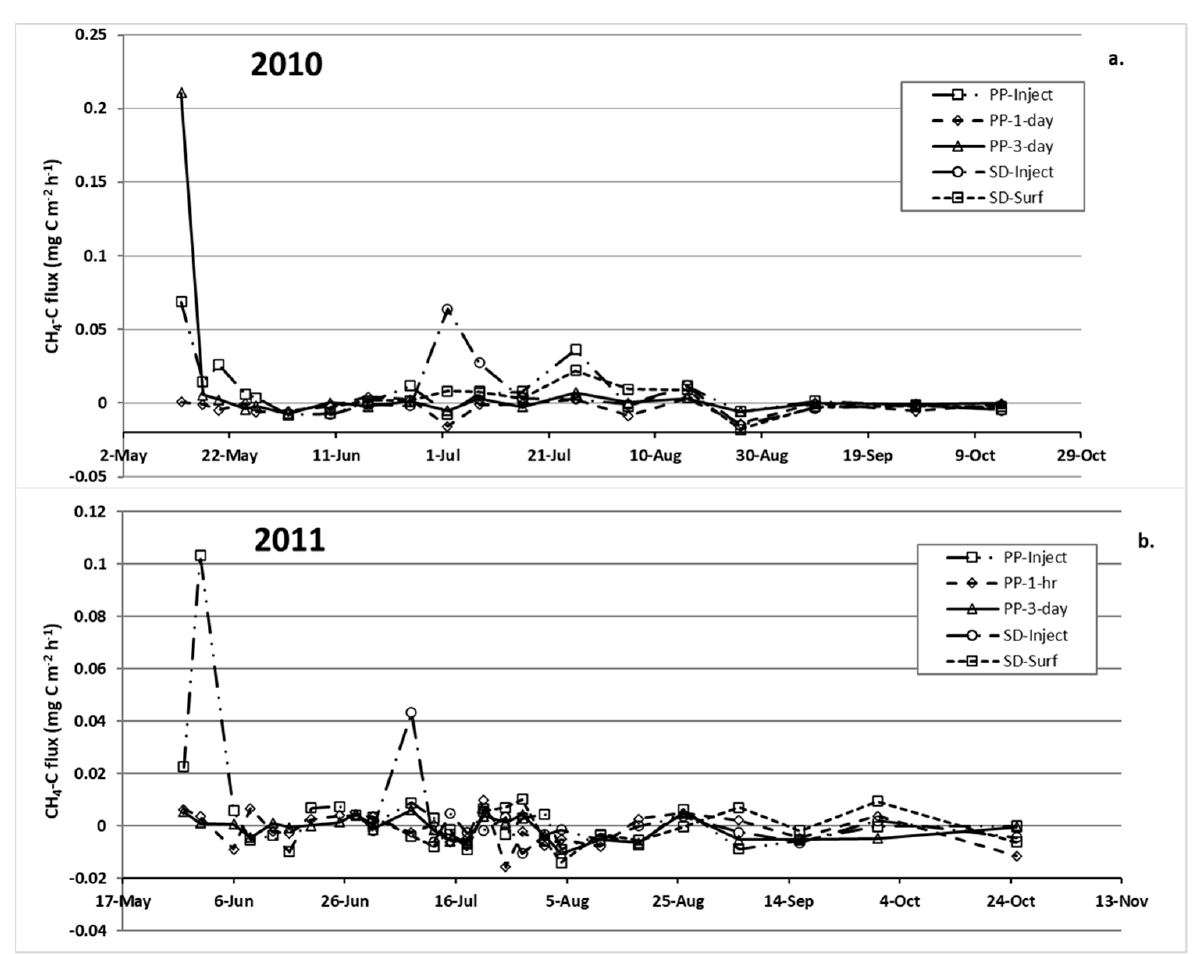
Figure 6. Methane (CH 4 -C) fluxes (mg m − 2 h − 1 ) for 2010 ( a ) and 2011 ( b ).